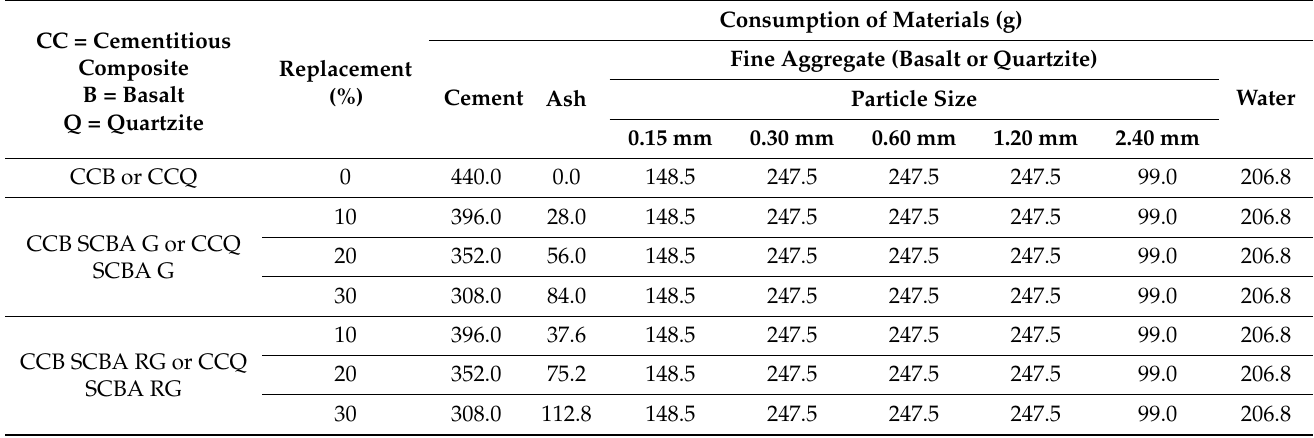
Table 1. Proportions of materials used in mortars.